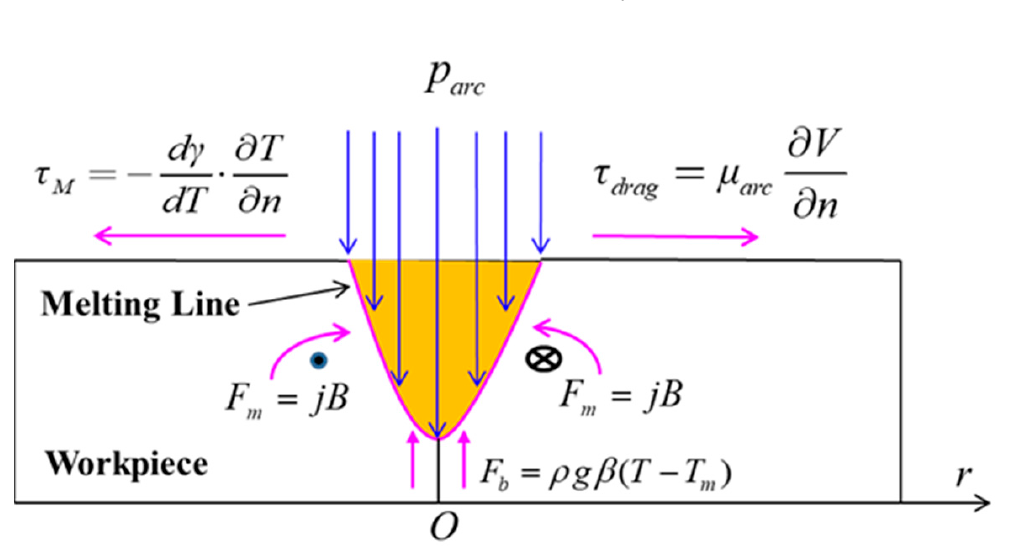
Figure 3. All the driving forces in weld pool.